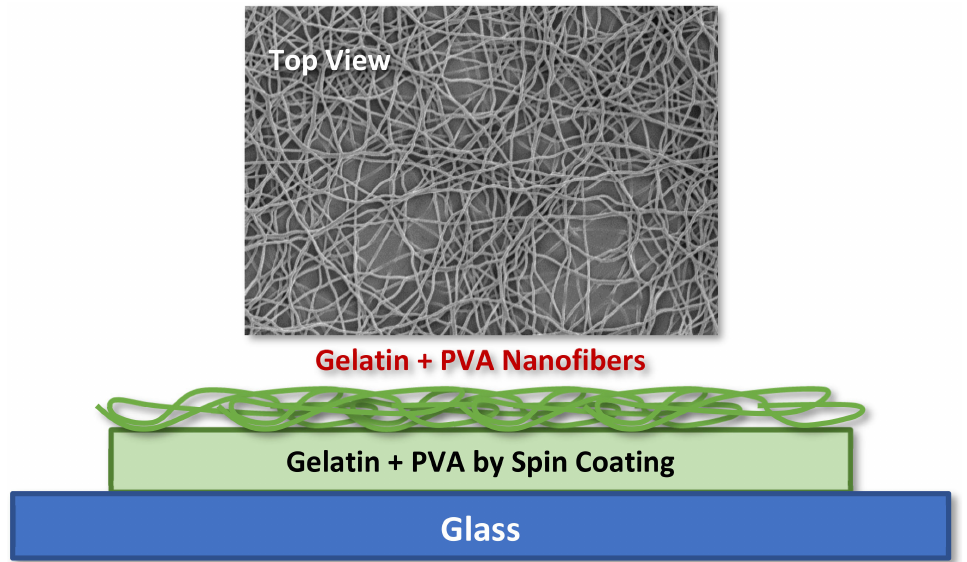
Figure 1. Morphology of electrospun gelatin/PVA mixed nanofibers on top of a film made of identical material.